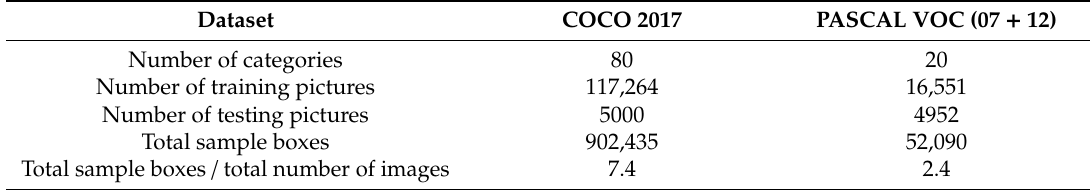
Table 2. Comparison of the di ff erences between the PASCAL VOC and COCO datasets.